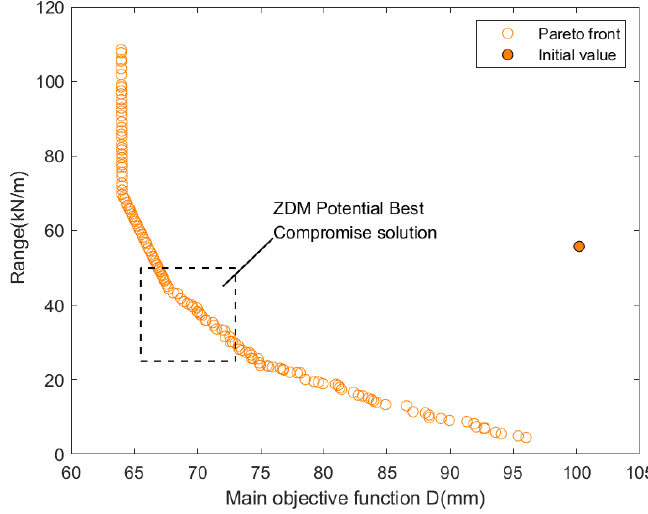
Figure 12. The individual Pareto front solution set of ZDM.